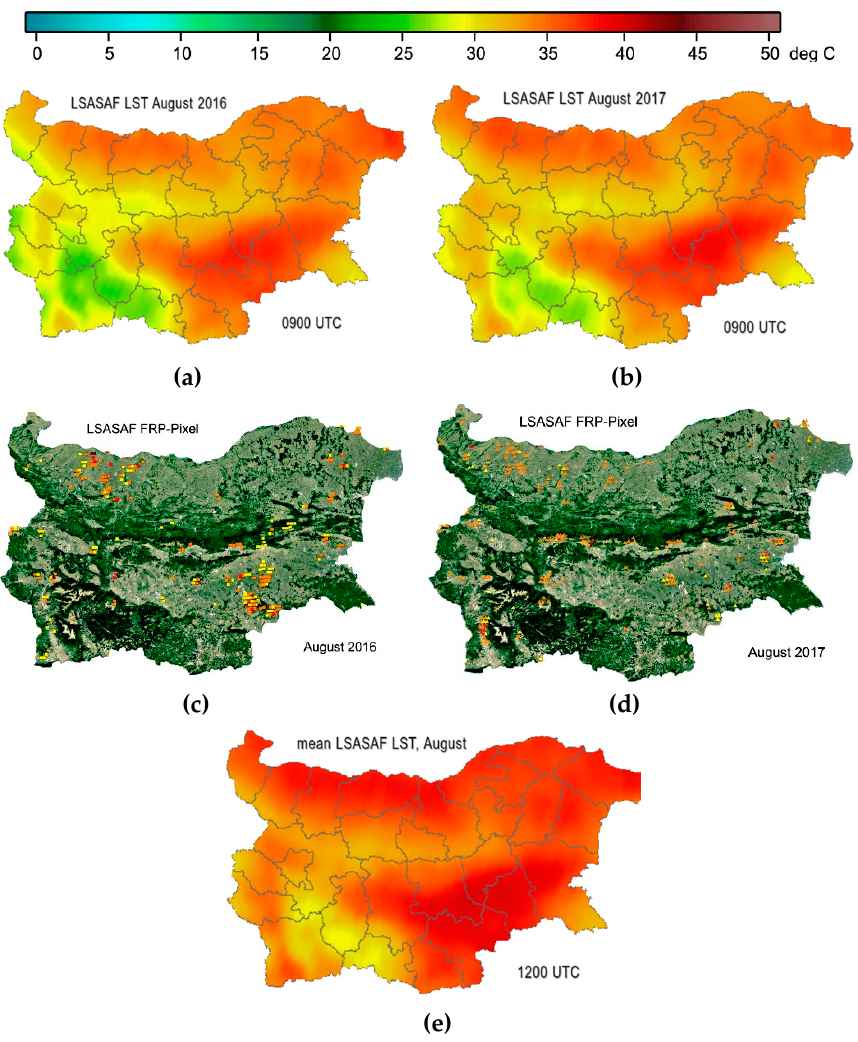
Figure 9. Land surface state and probable fire occurrence: Monthly mean LSASAF LST 0900 UTC for ( a ) August 2016 and ( b ) August 2017. Thermal anomaly detections by LSASAF FRP-Pixel product for ( c ) August 2016 and ( d ) August 2017. Monthly mean (2007–2018) LSASAF LST 1200 UTC values for ( e ) August.